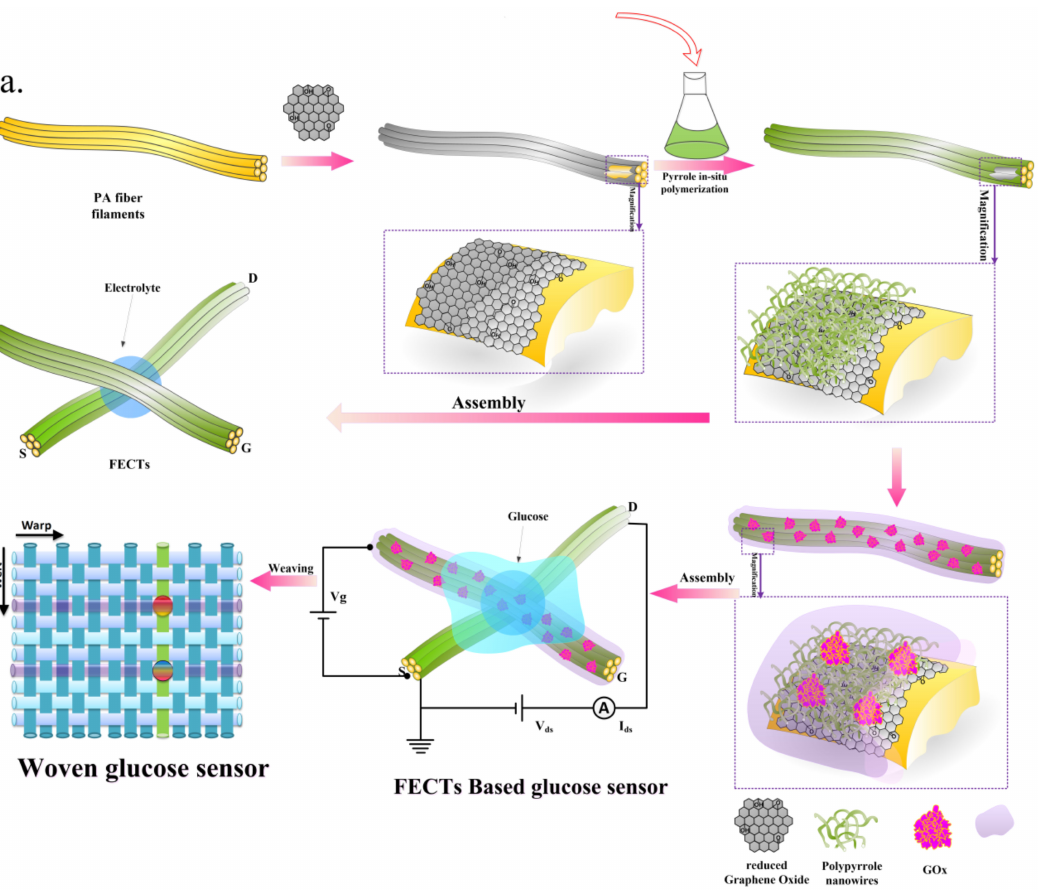
Figure 11. Schematic diagram of glucose sensors based on fiber organic electrochemical transistors with active layer of PPy nanowires and rGO. Reprinted from [119]. Copyright 2017, with permission from